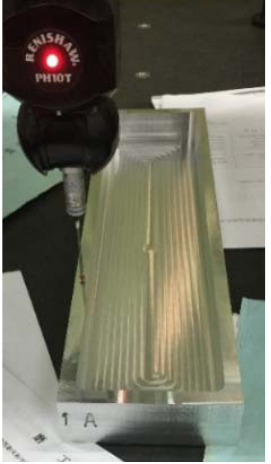
Figure 5. Deformation measurement of thin ‐ walled part.